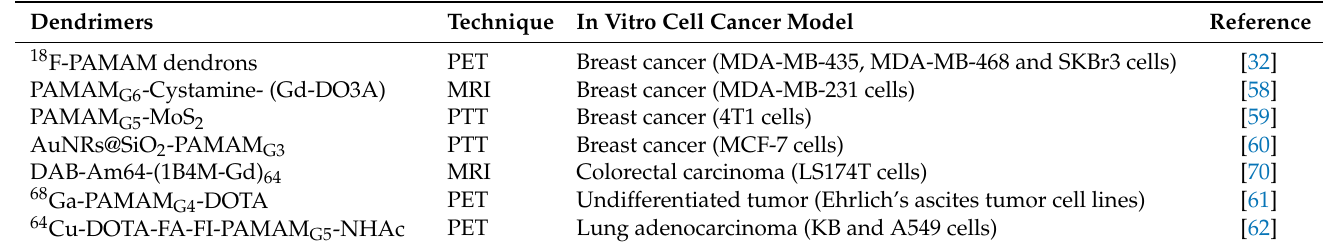
Table 3. The use of dendrimers, selected in this review, for bioimaging and theranostic applications. Dendrimers Technique In Vitro Cell Cancer